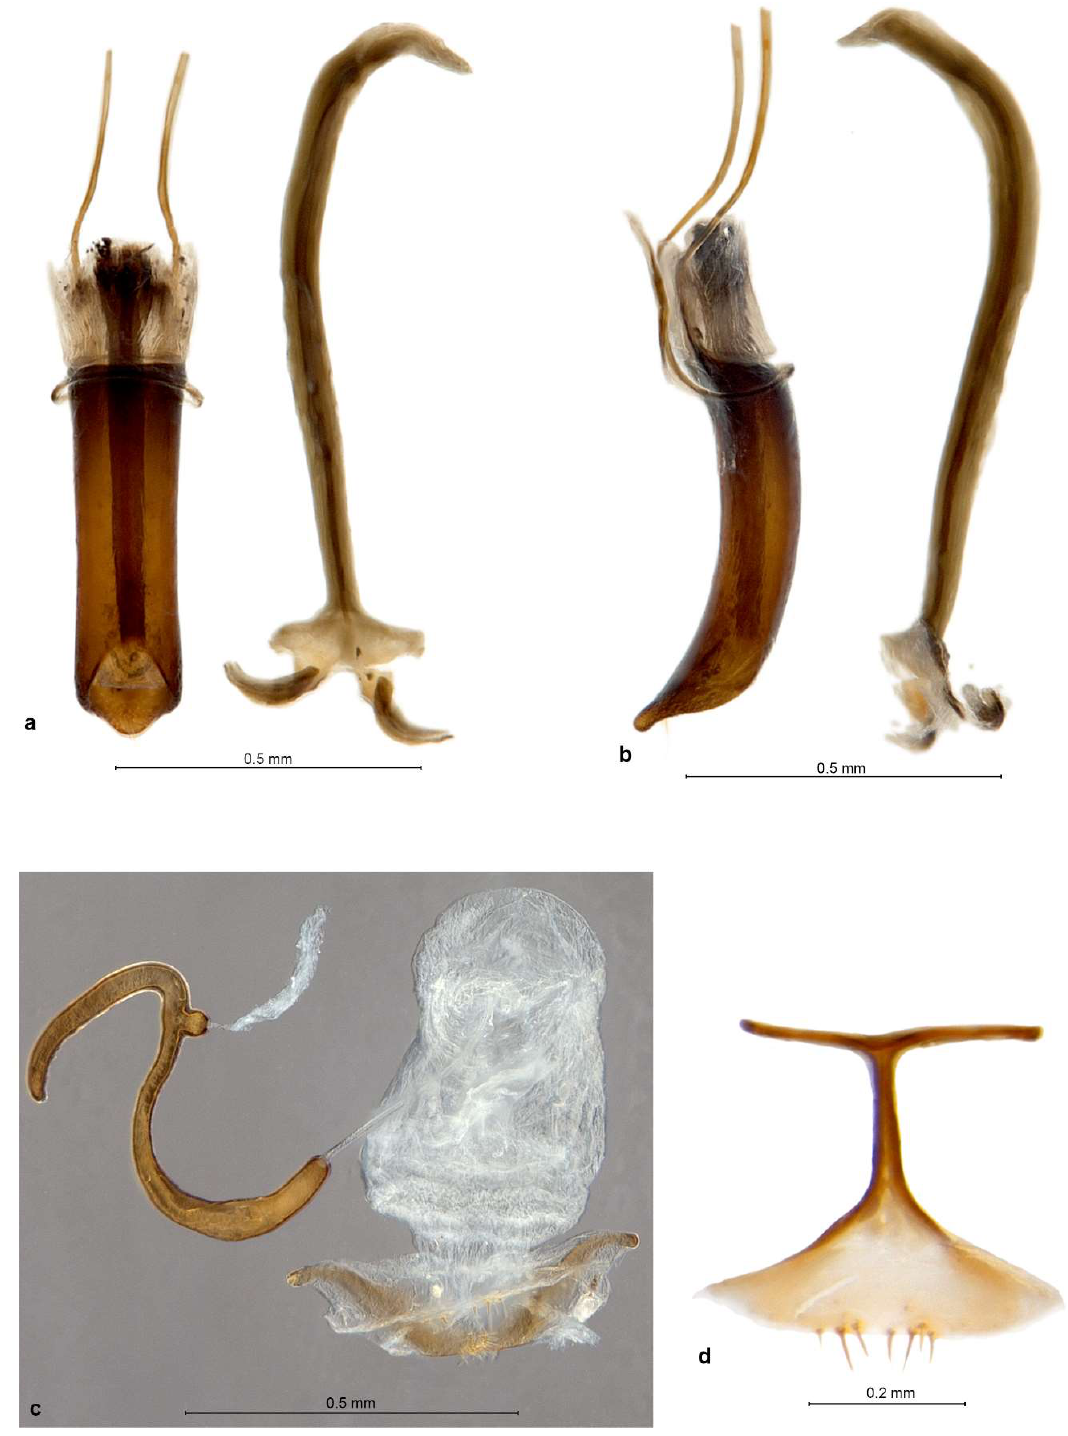
Figure 9. Philetaerobius garibebi sp. n. (Karibib), genitalia. ♂ , aedeagus and sternite IX, dorsal view ( a ); ditto, left lateral view ( b ); ♀ , ovipositor and spermatheca, dorsal view ( c ); ♀ , sternite VIII, dorsal view ( d ).